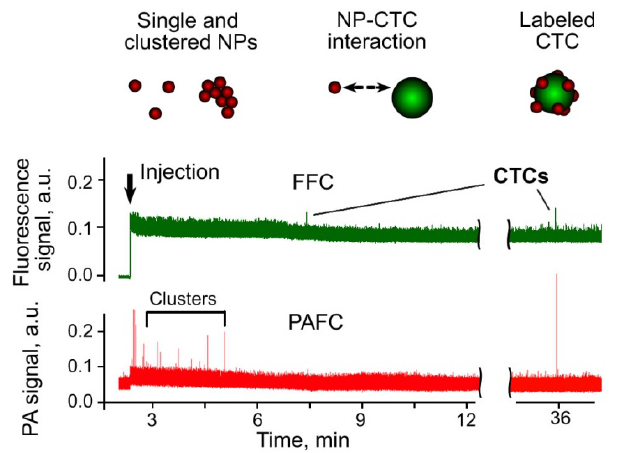
Figure 9. In vivo multimodal PA (red trace) and fluorescence (green trace) detection of CTCs (C8161-GFP) in a tumor-bearing mouse model with functionalized MNPs and GFP as PA and fluorescent contrast agents, respectively. Black arrow marks the moment of NP injection. Wavelength and energy fluence/intensity for PAFC and FFC: 820 nm and 50 mJ/cm 2 and 488 nm and 80 W/cm 2 ,